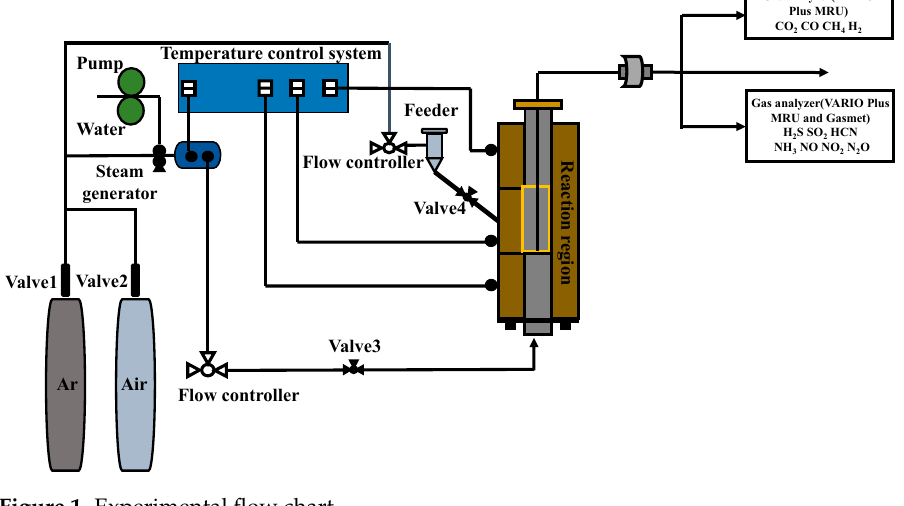
Figure 1. Experimental flow chart.